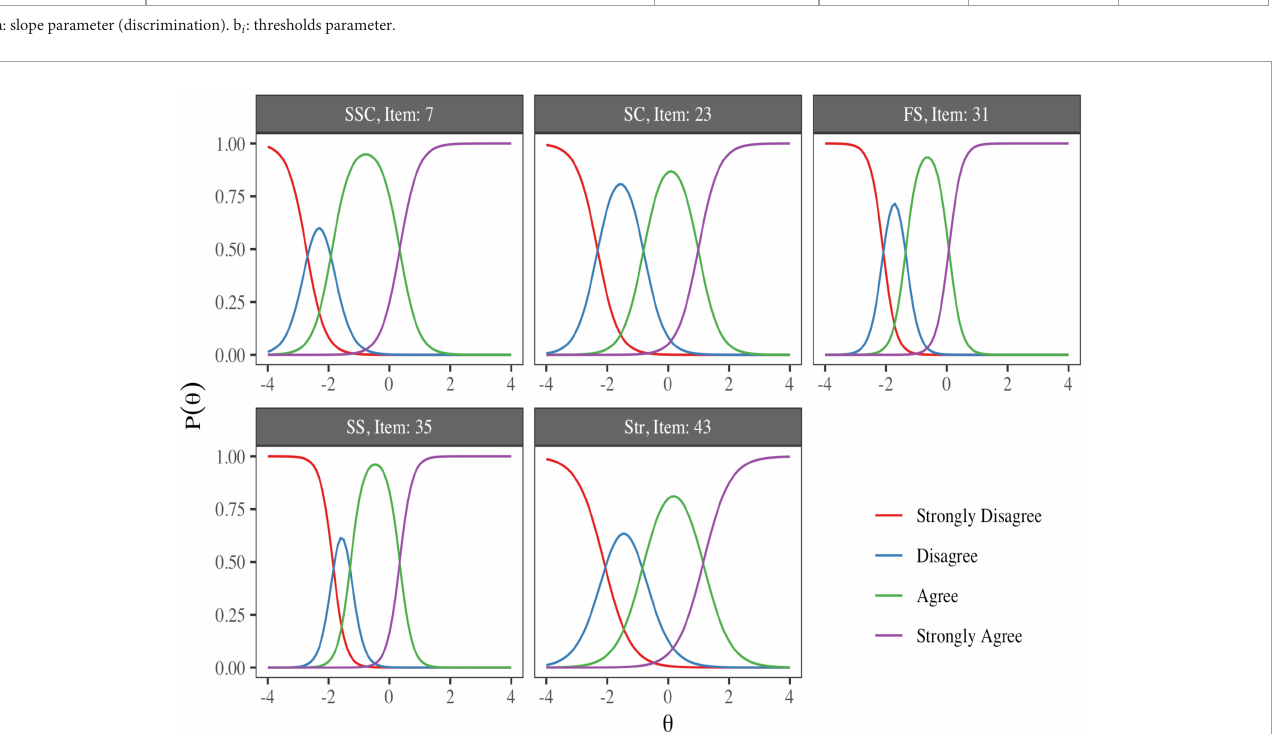
FIGURE1 Item characteristic curves with the greatest discrimination from each factor of the resilience measurement scale (RESI-M) scale. The ICCs reveal the GRM response predictions at different levels of the Strength and Self-Confidence (SSC), Social Competence (SC), Family Support (FS), Social Support (SS), and Structure (Str)